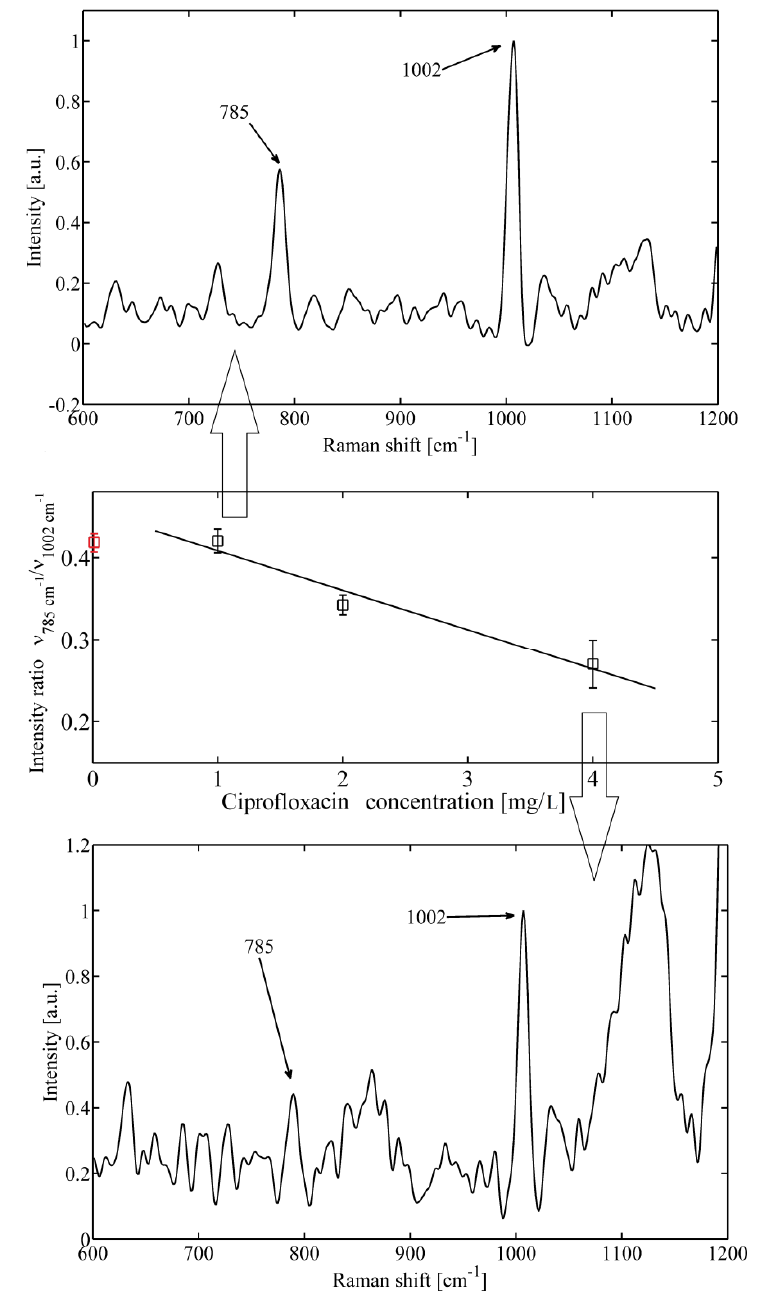
Figure 2. An example of Staphylococcus epidermidis response to bactericidal action of ciprofloxacin. ( a ) Top—Raman spectrum obtained for low antibiotic concentration (1 mg/L). The DNA peak at 785 cm − 1 is clearly visible together with phenylalanine peak at 1002 cm − 1 , ( b ) Middle—mean value of ratio of maximum of Raman intensity at 785 cm − 1 versus 1002 cm − 1 for different concentration of applied ciprofloxacin measured from 10 different cells. Mean value of a control sample not exposed to antibiotic (red circle) is shown. ( c ) Bottom— Raman spectrum obtained for higher antibiotic concentration (4 mg/L). The DNA peak at 785 cm − 1 disappeared which indicates fragmentation of DNA. Note that the two peaks shown here (around 1130 cm -1 ) could not be reliably determined from the analysis of the